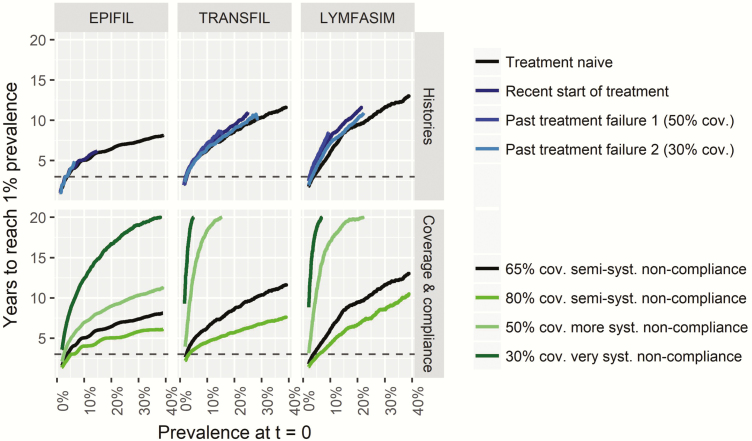
The association between the average time needed to reach the 1% target of microfilariae (mf) prevalence and mf prevalence at t = 0, for programs based on annual distribution of diethylcarbamazine + albendazole in the African region. The upper panels show how the history of control affects this association, assuming that coverage is 65% from t = 0 onward, independent of the history of control. The lower panels show how the program duration in treatment-naive settings depends on achieved coverage and compliance patterns from t = 0 onward. Horizontal line at t = 3 indicates 2020. Note that the black lines in the upper and lower panels per model are the same. Abbreviations: cov., coverage; syst., systematic.